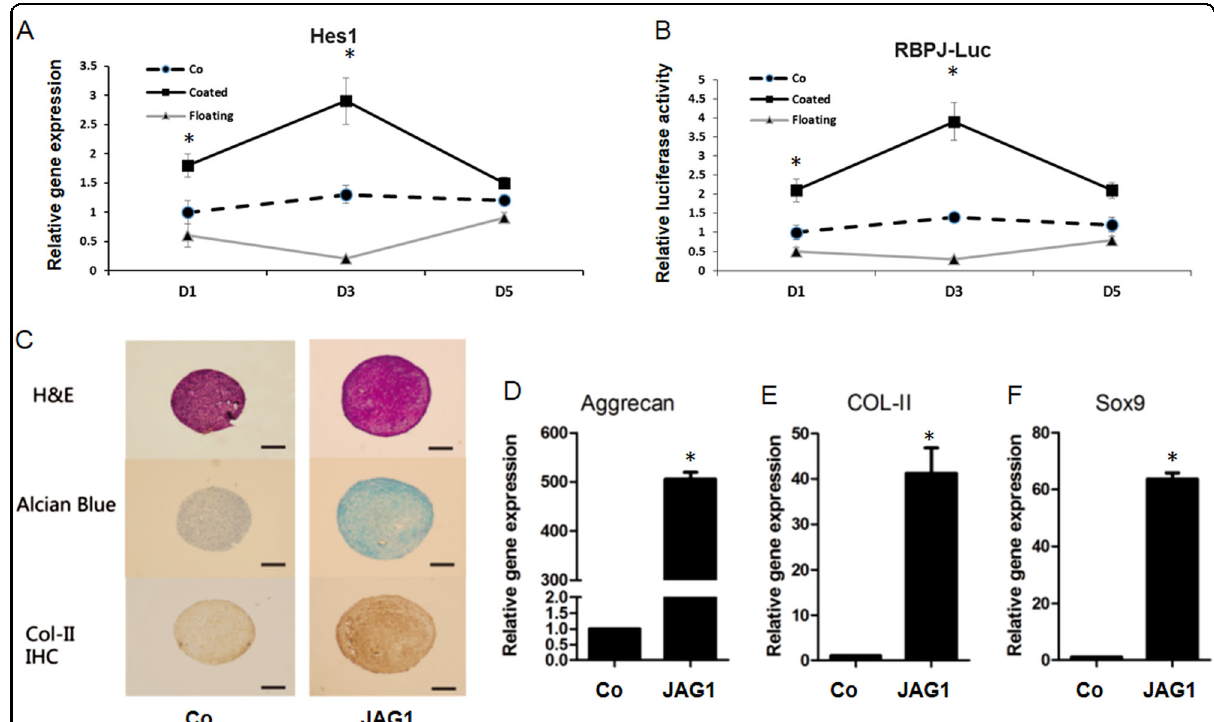
Fig. 3 Inhibition of Notch signaling by unbound JAG1 enhances inducted PMSC chondrogenic differentiation. a Quanti fi cation of gene expression of the Notch target gene Hes1 indicates a signi fi cant increase ( p < 0.05) in cells with surface-bound (coated) JAG1 (10 µg/ml) treatment, and a reduced expression was observed in cells treated with a single treatment of unbound (Floating) JAG1 (10 µg/ml) for up to 5 days. b Luciferase assays showed a signi fi cant decrease in Notch-responsive reporter activity in bound JAG1-treated MSCs and reduced activity in day 1 and day 3 with unbound JAG1 treatment. The data are the means ± SD of three independent experiments performed in duplicate, and the gene expression level in control cells (Co) was set at 1 (* p < 0.05 compared with control). c An increase in chondrogenesis was observed in unbound JAG1-treated PMSCs at day 14, with stronger staining of alcian blue and type II collagen (Col-II). Scale bars, 100 µm. d – f Quanti fi cation of gene expression of cartilage